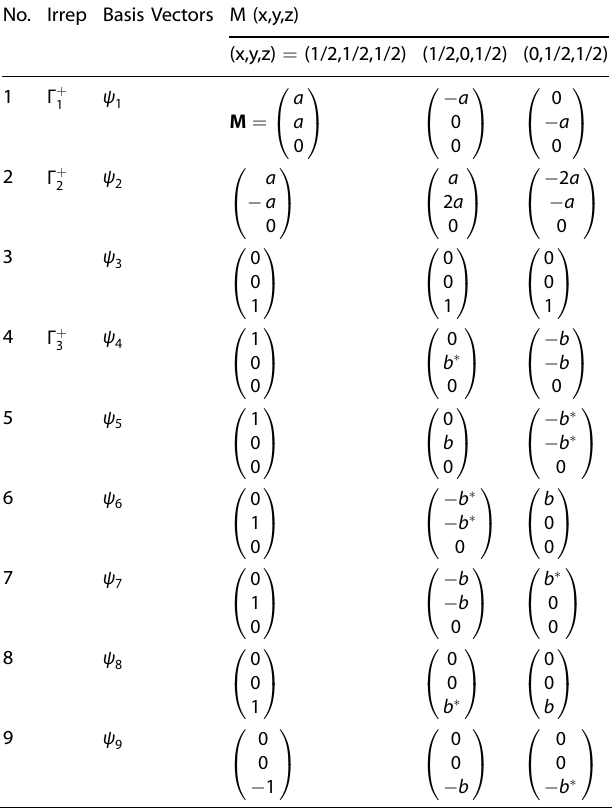
Table 1. The irreducible representations allowed by symmetry and their corresponding basis vectors and moment components.